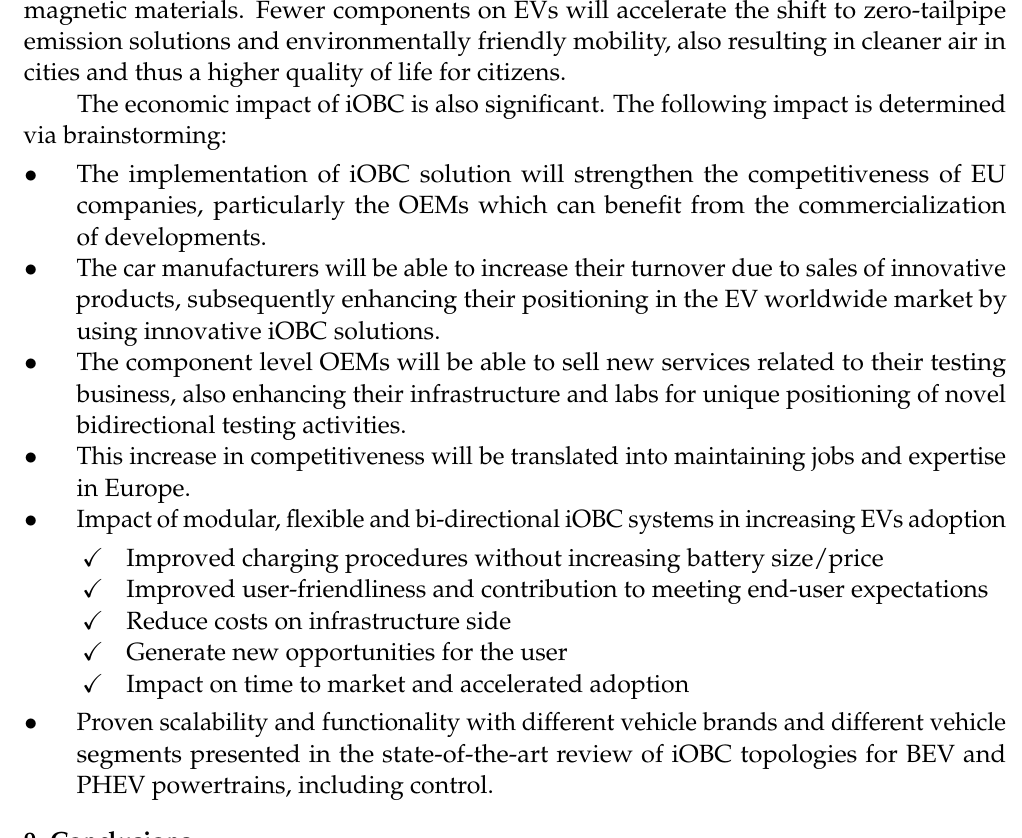
Figure 40. Publication status of top 15 higher educational institutions for iOBC for electric vehicles from 2010 to until 2022.